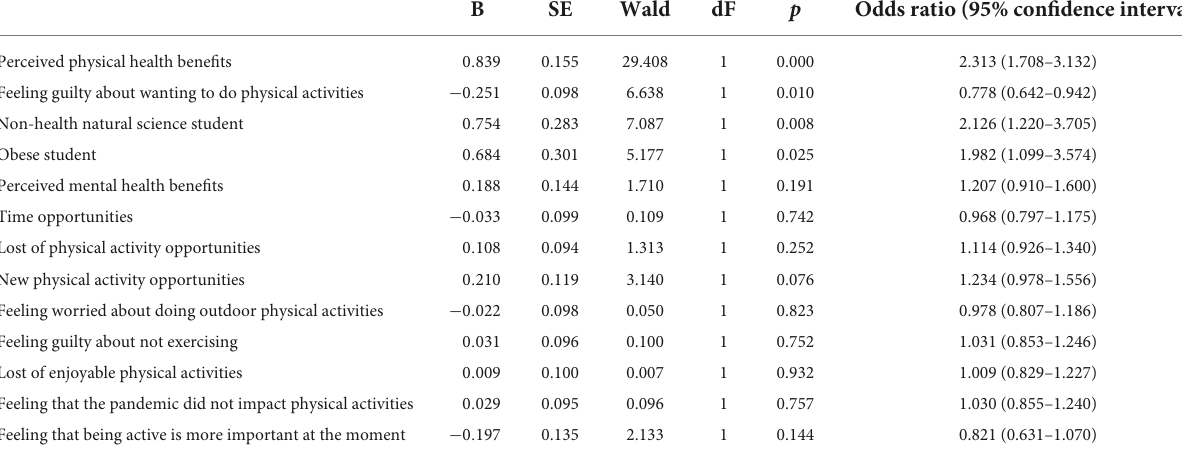
TABLE 4 Predictors of meeting the physical activity (PA)